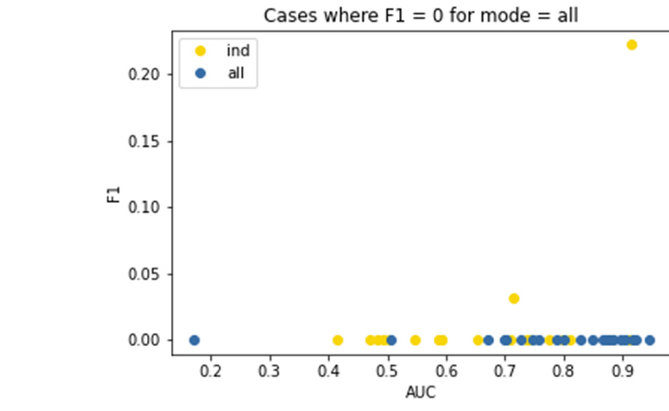
( b ) Figure 3. ( a ) AUC and F1 score for the different models and modes at Caltech for standard feature set; ( b ) AUC and F1 score for the different models and modes at Caltech for augmented feature set. To further investigate which mode is favorable, we examined all predictions of the